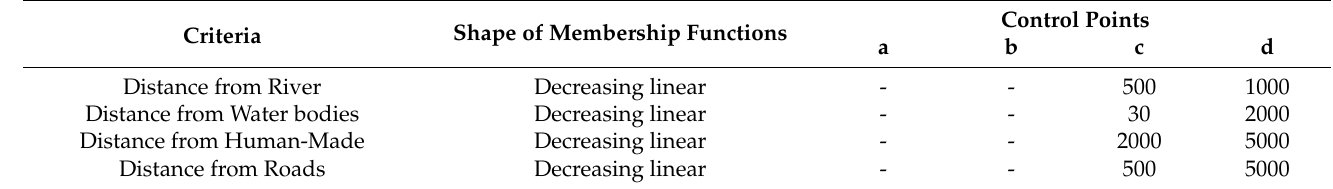
Table 2. The shape of membership functions and control points of different